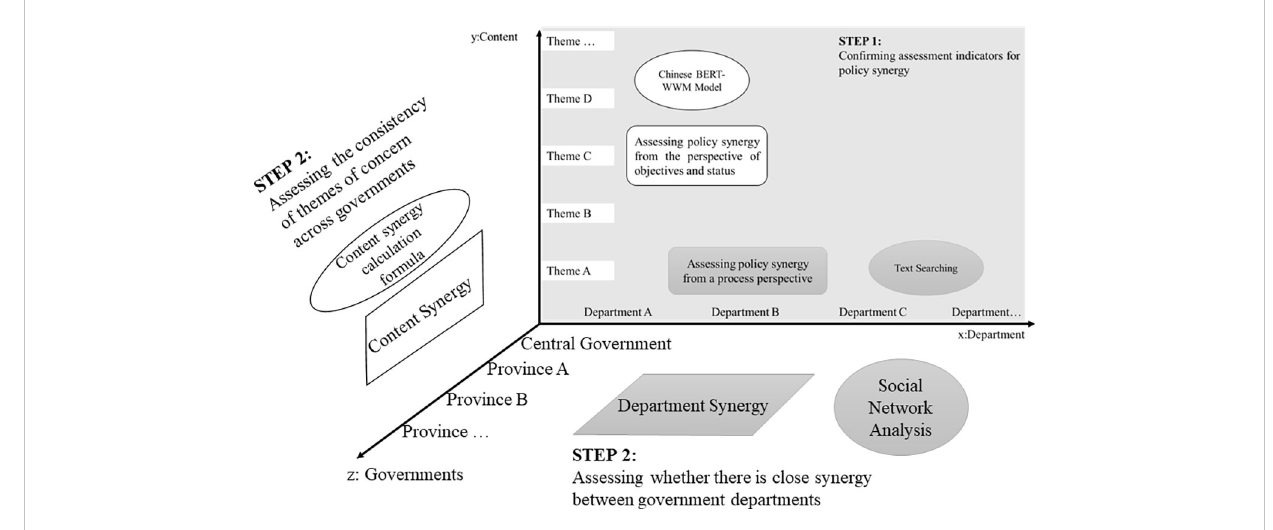
FIGURE 1 Research